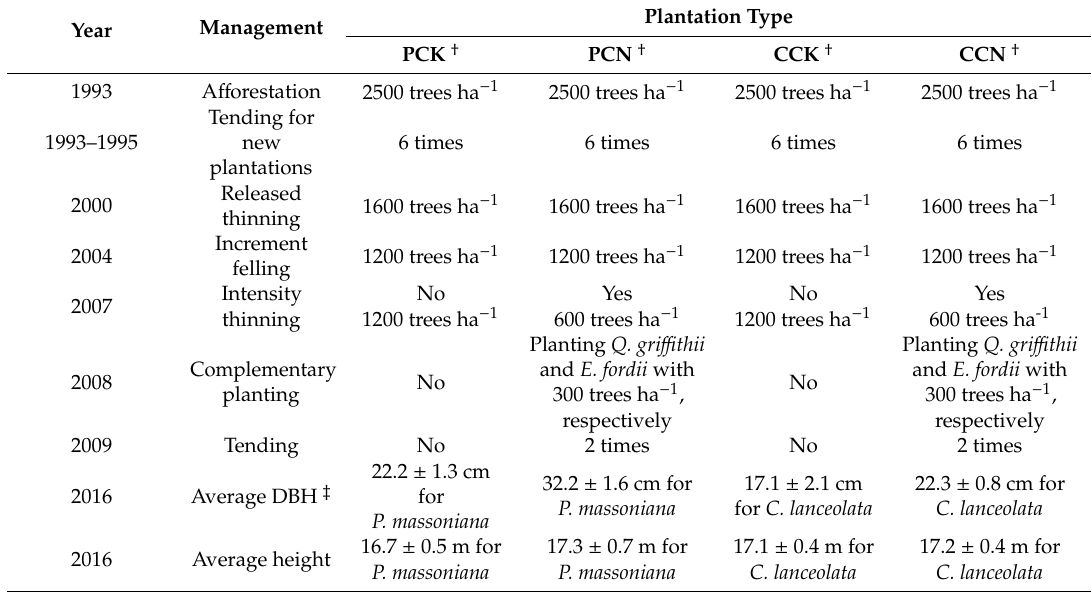
Table 1. Basic information and management history of the four plantations.